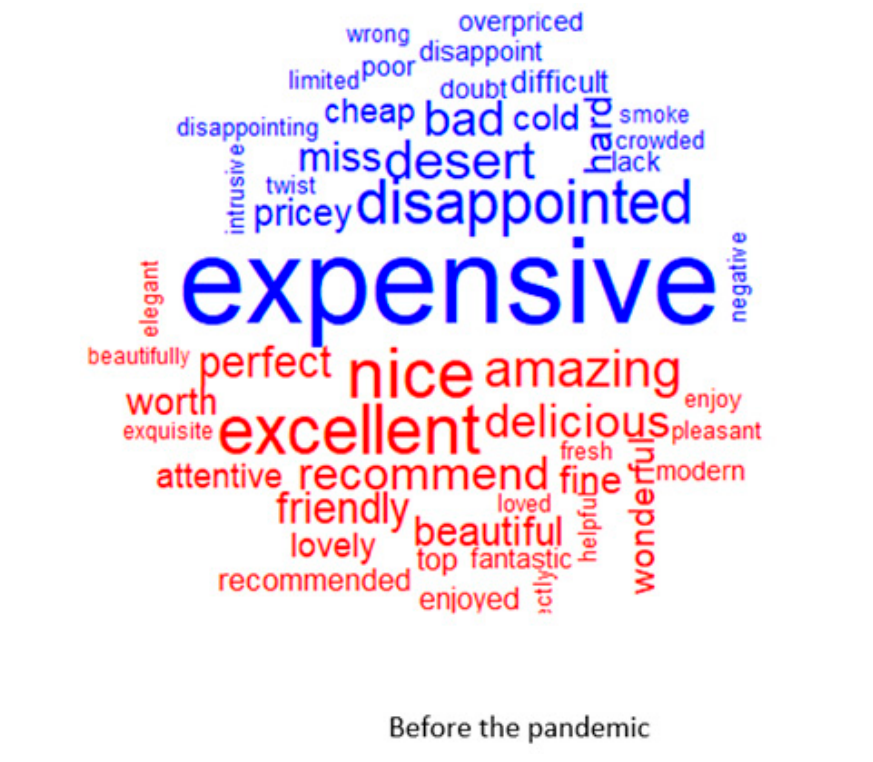
Figure 4. Most common positive and negative words in reviews before and during pandemic.